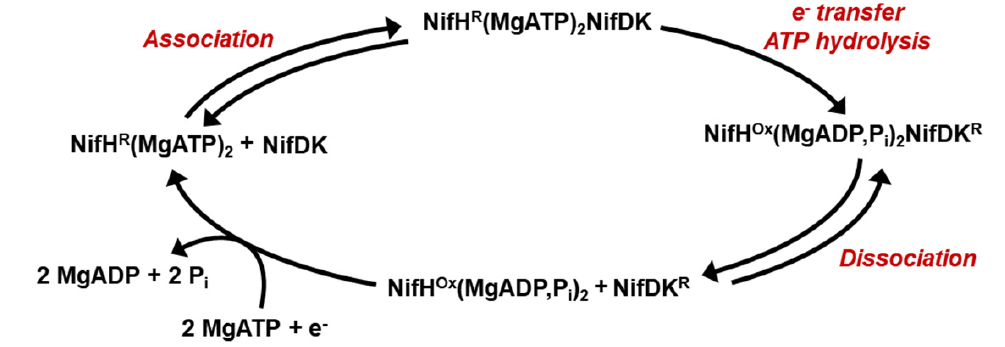
Figure 7. The Fe protein cycle. This cycle depicts the function of NifH as a reductase component of nitrogenase to facilitate the interprotein electron transfer, concomitant with ATP hydrolysis, to its catalytic partner NifDK via repeated association and dissociation. NifH R , reduced NifH; NifH Ox , oxidized NifH; NifDK R , reduced NifDK.